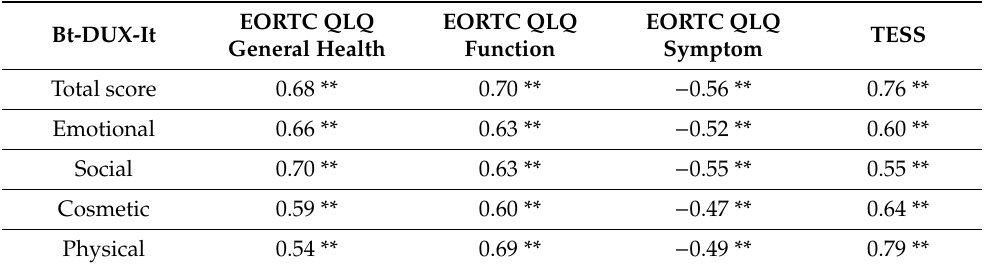
Table 3. Spearman correlation coe ffi cients between the total Bt-DUX-It, Bone tumour Dux Italian version, scores and EORTC and functional ability. QLQ, Quality of Life Questionnaire.